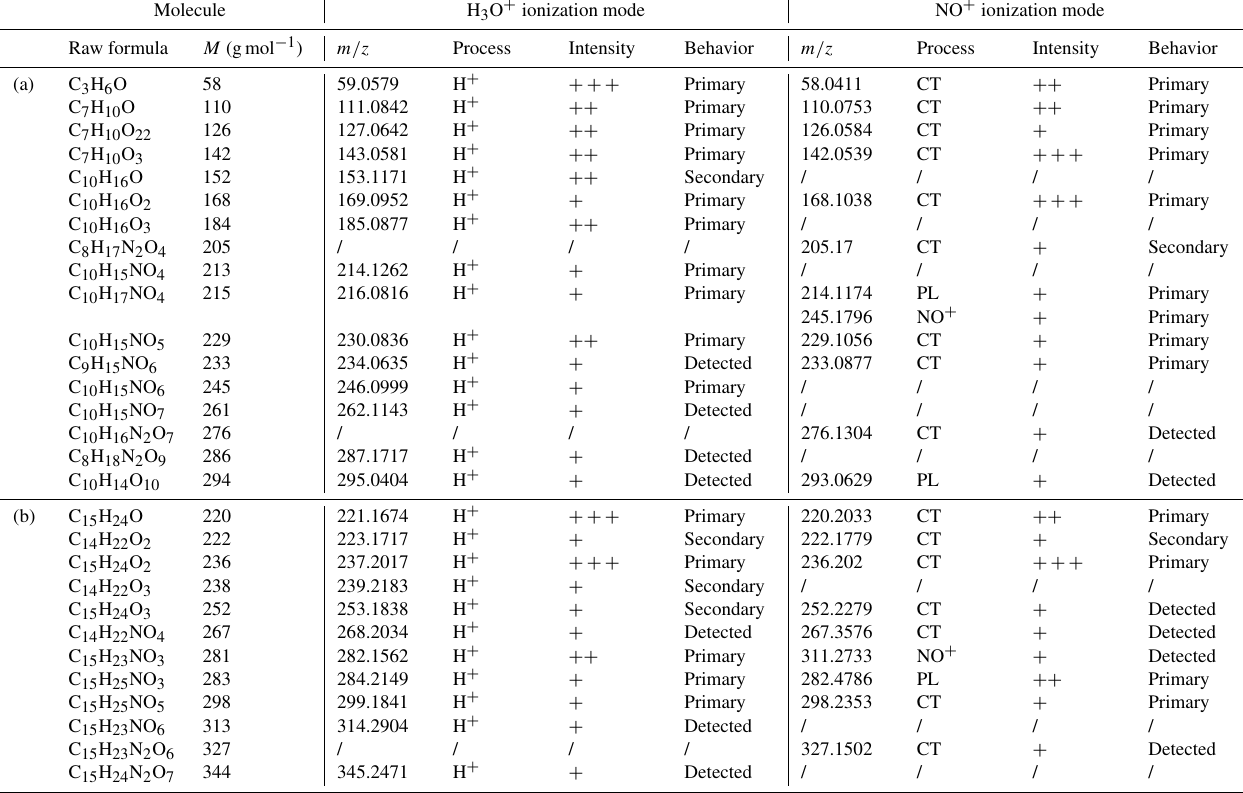
Table 4. Products detected for terpinolene (a) and β -caryophyllene (b) with PTR-ToF-MS H 3 O + and NO + ionization modes: formulae and molar masses, detected masses, ionization processes (H + : proton adduct; NO + : NO + adduct; CT: charge transfer; PL: proton loss), peak intensity, and